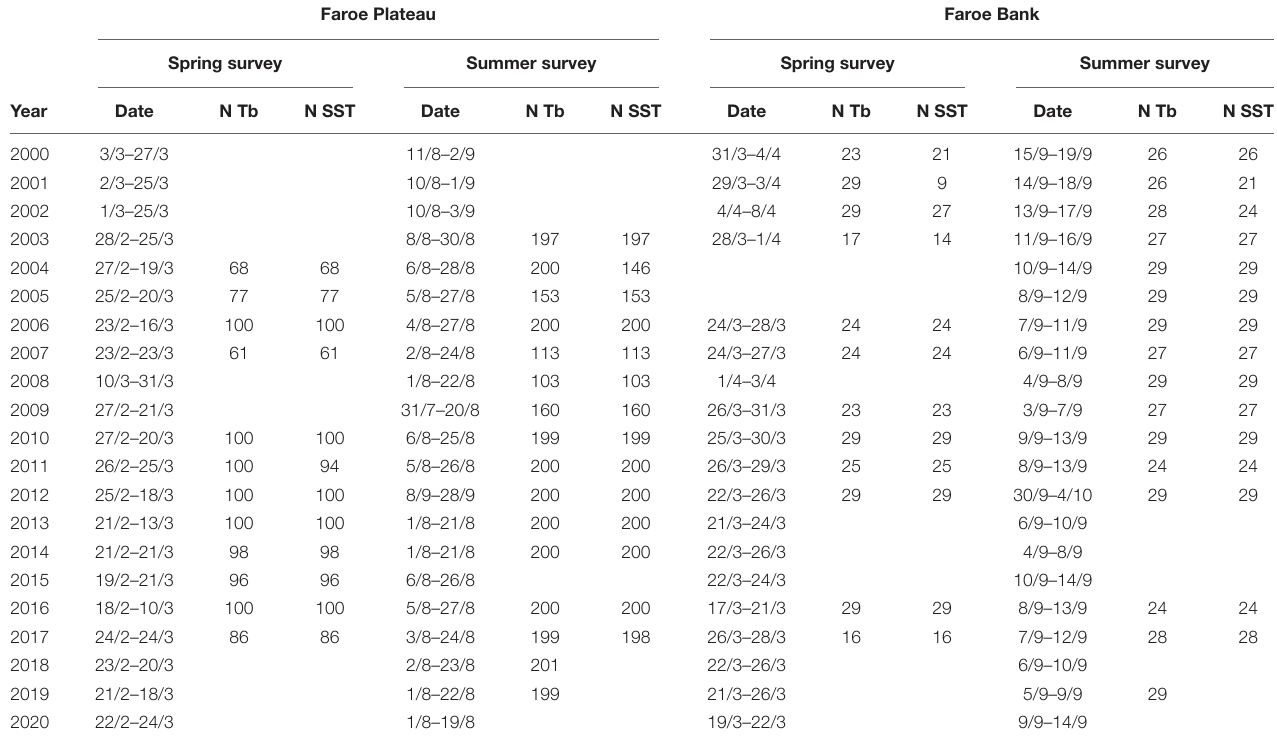
TABLE 1 | Year, date and number (N) of stations where bottom temperatures (Tb) and sea surface temperatures (SST) were registered in the annual spring- and summer groundfish surveys on the Faroe Plateau and on the Faroe Bank. Faroe Plateau Faroe